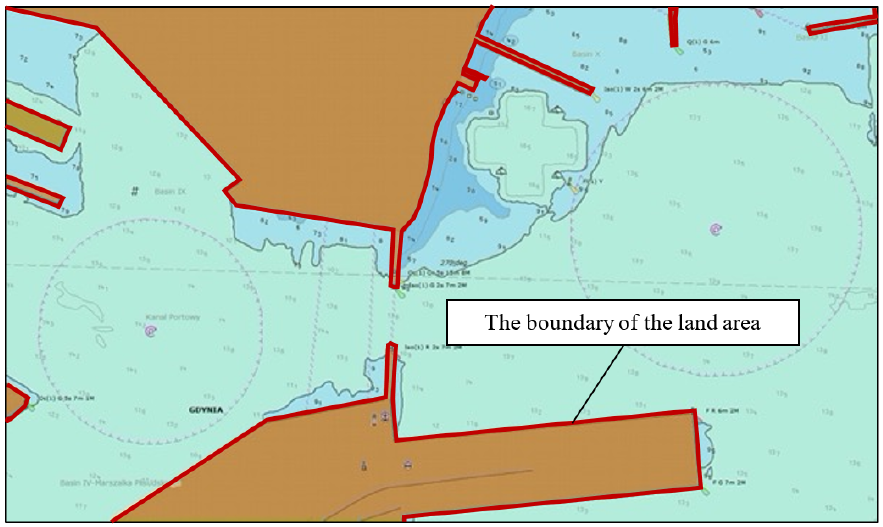
Figure 2. Image of the electronic navigational chart No. PL5GDYNA.000 in the Mercator cartographic projection with the border of the land area